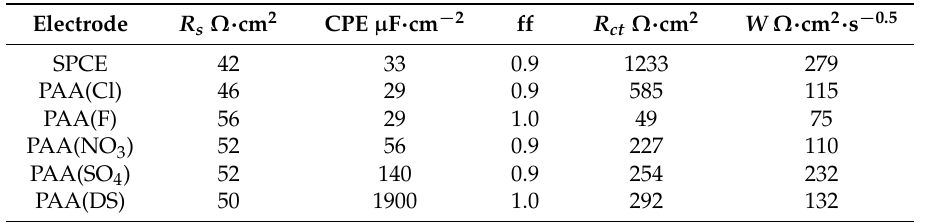
Figure 4. Nyquist plots of a bare SPCE (A), black line) and the different PAA(anion) films-modified SPCEs herein prepared, polarized at 0.12 V, measured in 5 mM potassium ferrocyanide and 0.1 M KCl aqueous solution. The perturbation frequency range was from 65 KHz to 10 mHz with an amplitude of 5 mV rms. The stabilization time was 60 s. The inset shows the equivalent circuit where R s is the uncompensated resistance, R ct is the charge transfer resistance, CPE is the constant-phase element and W is the Warburg impedance. The points represent experimental data and the lines correspond to the fittings. Table 1. Values of the equivalent circuit elements obtained by fitting the experimental results shown in Figure 4.